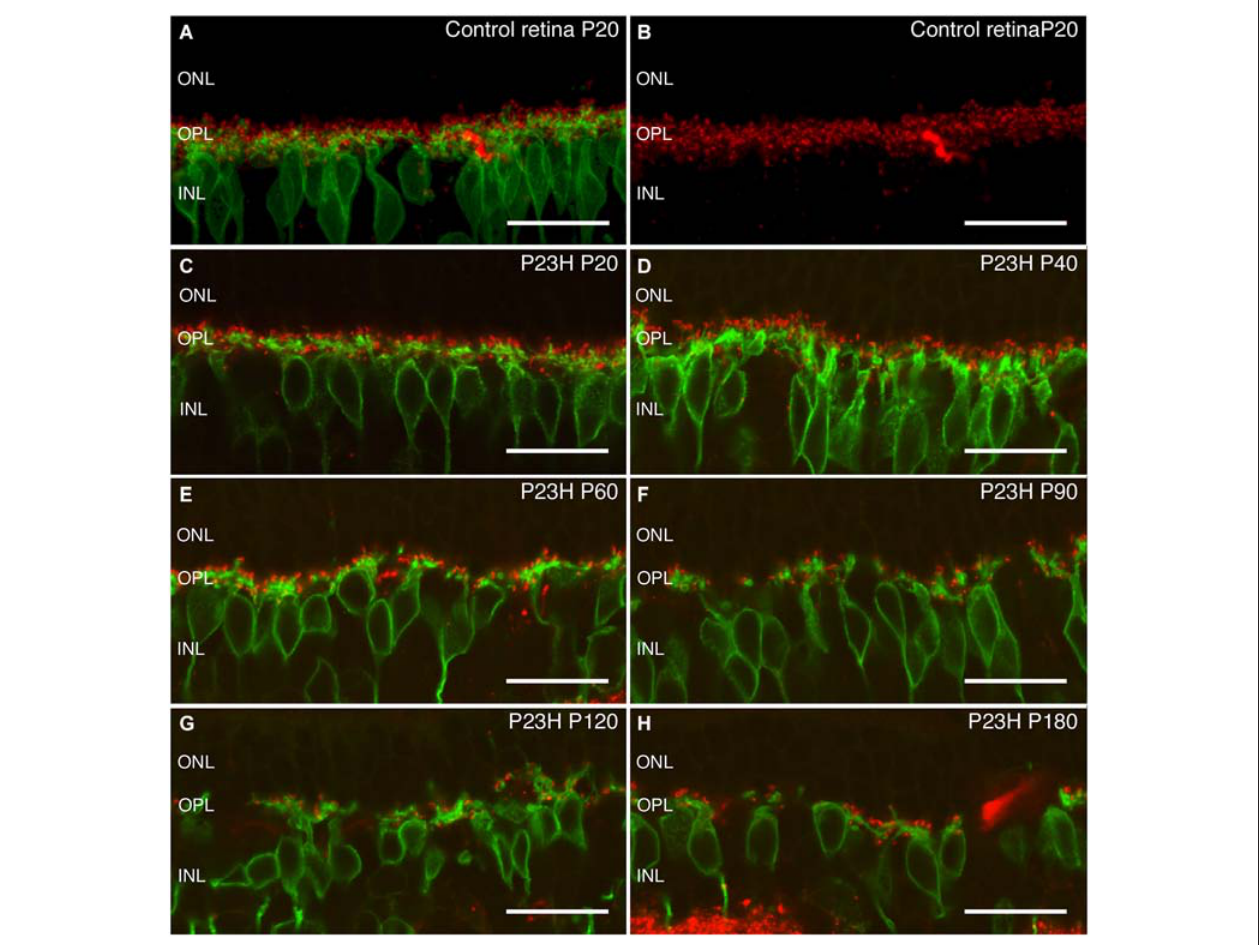
photoreceptor cells at the OPL level (A,B) . At P20, the P23H retina (C) already shows a small decrease as compared to control retinas. During aging (C–H) , there is a continuous reduction in the number of the synaptic contacts. ONL: outer nuclear layer; OPL: outer plexiform layer; INL: inner nuclear layer. Scale bar: 20 µ